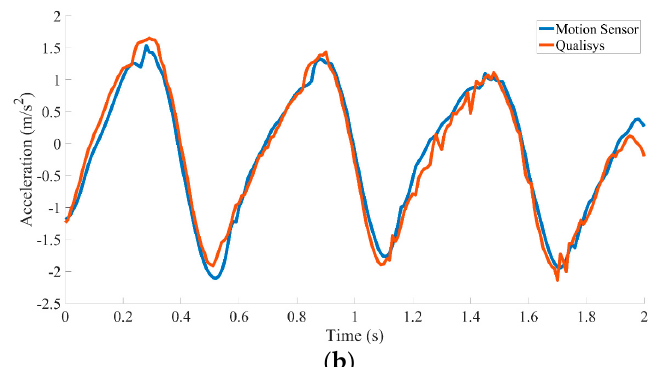
Figure 8. Data from a representative participant showing a comparison of the angular velocity and acceleration between the motion sensor and optical motion capture system. The blue line represents the motion sensor, and the orange line represents the optical motion capture system. ( a ) The angular velocity between the right leg and transverse plane in the 10-m walking test. ( b ) The acceleration of walking direction separated from the waist test point.